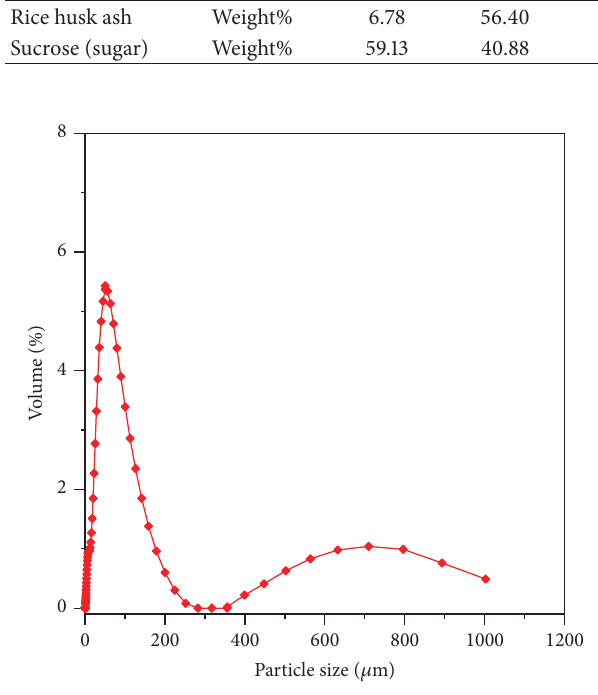
Figure 1: Distribution of particle size of the rice husk ash